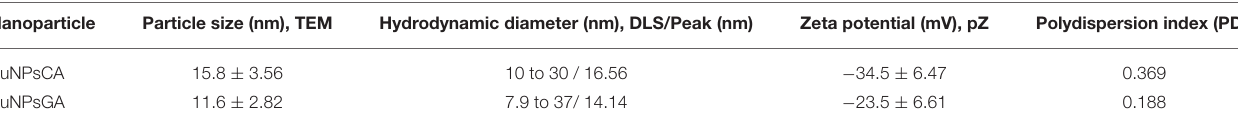
TABLE 1 | Comparative parameters between TEM and